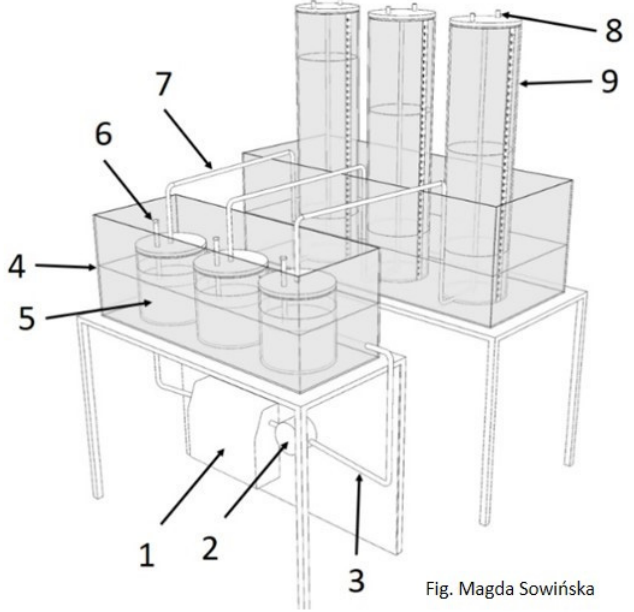
Figure 4. Diagram of the test stand for biogas efficiency, the so-called batch culture (3-chamber